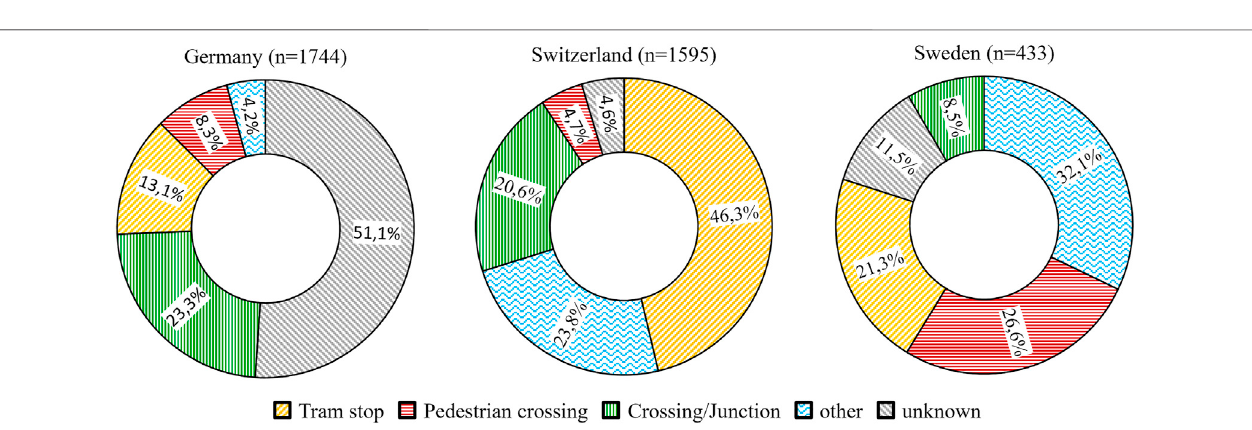
FIGURE 3 | Tram vs. Pedestrian Accidents by Site (3,772 accidents in